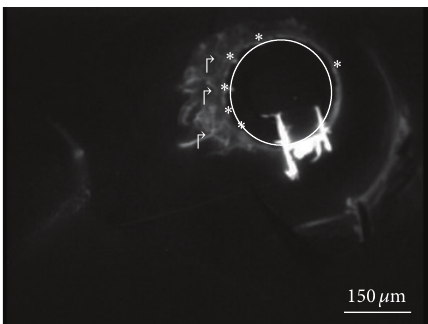
Figure 4: Filling of aqueous vein ( ↱ ) located in correspondence of the quadrant in which both Schlemm’s canal whose boundary was indicated by circle and the collectors ( ∗ ) were patent.